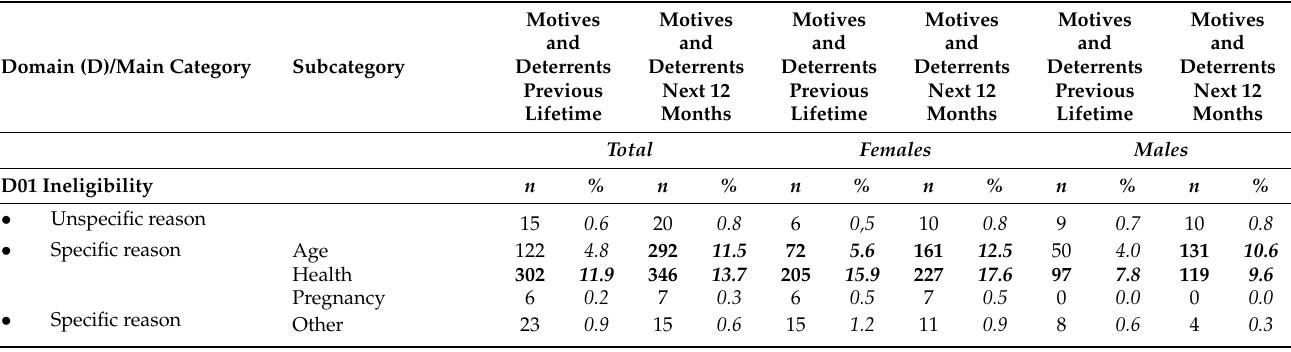
Table A3. Self-reported motivators and deterrents for retrospective (lifetime) and prospective (12 months) blood donation behaviour—results for overall study sample and separated by sex ( n = 2531, unweighted)